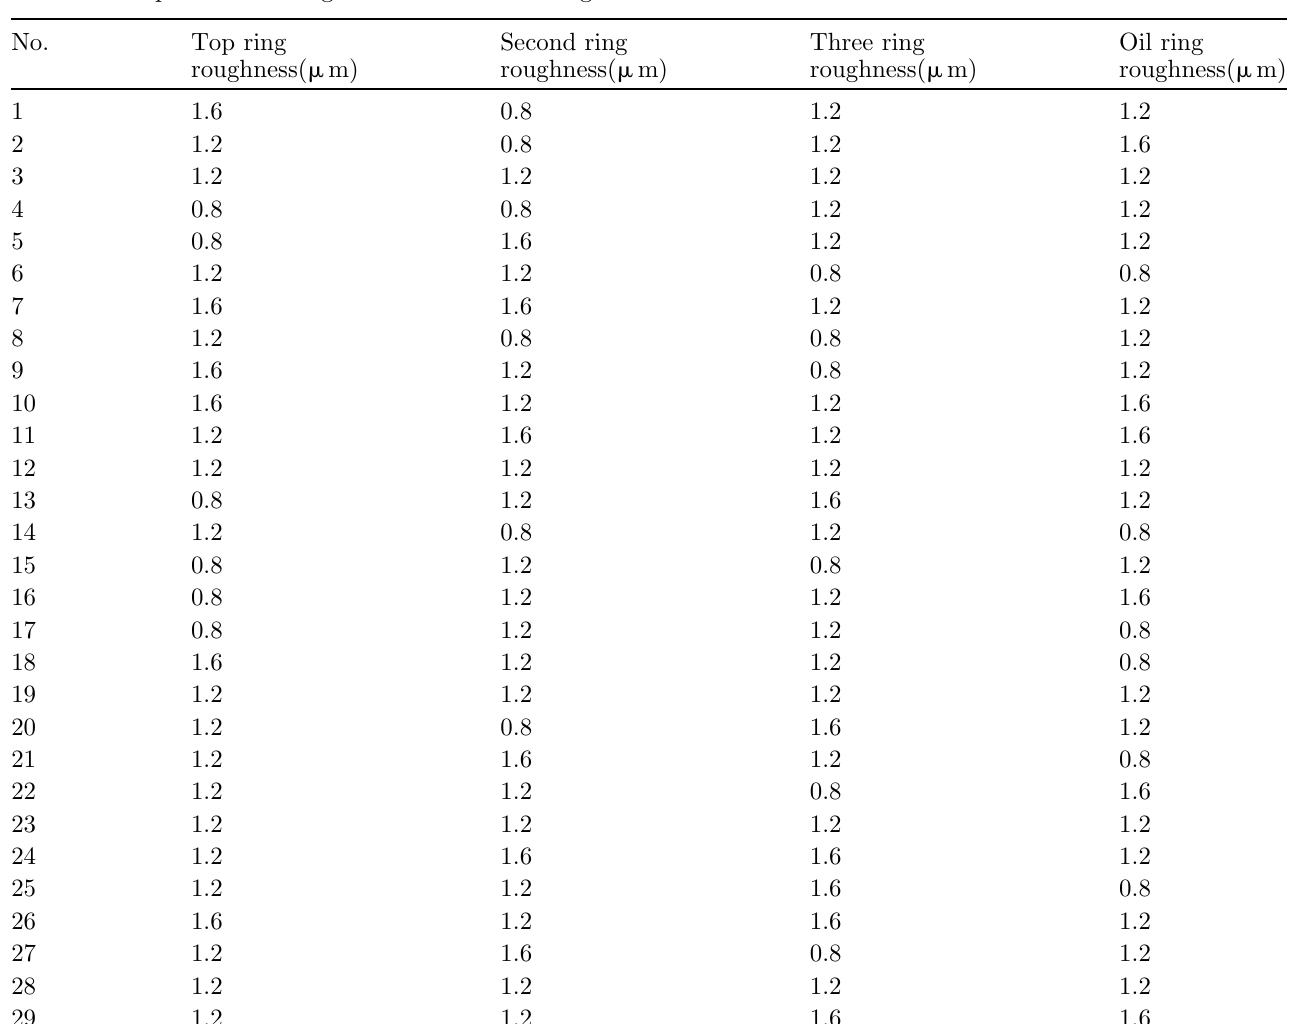
Table 5. Experimental design of Box-Behnken design.